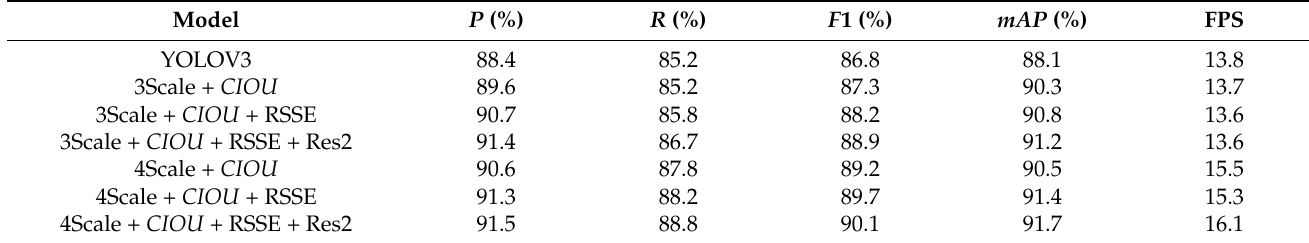
Table 3. Ablation results of different models (416 × 416).